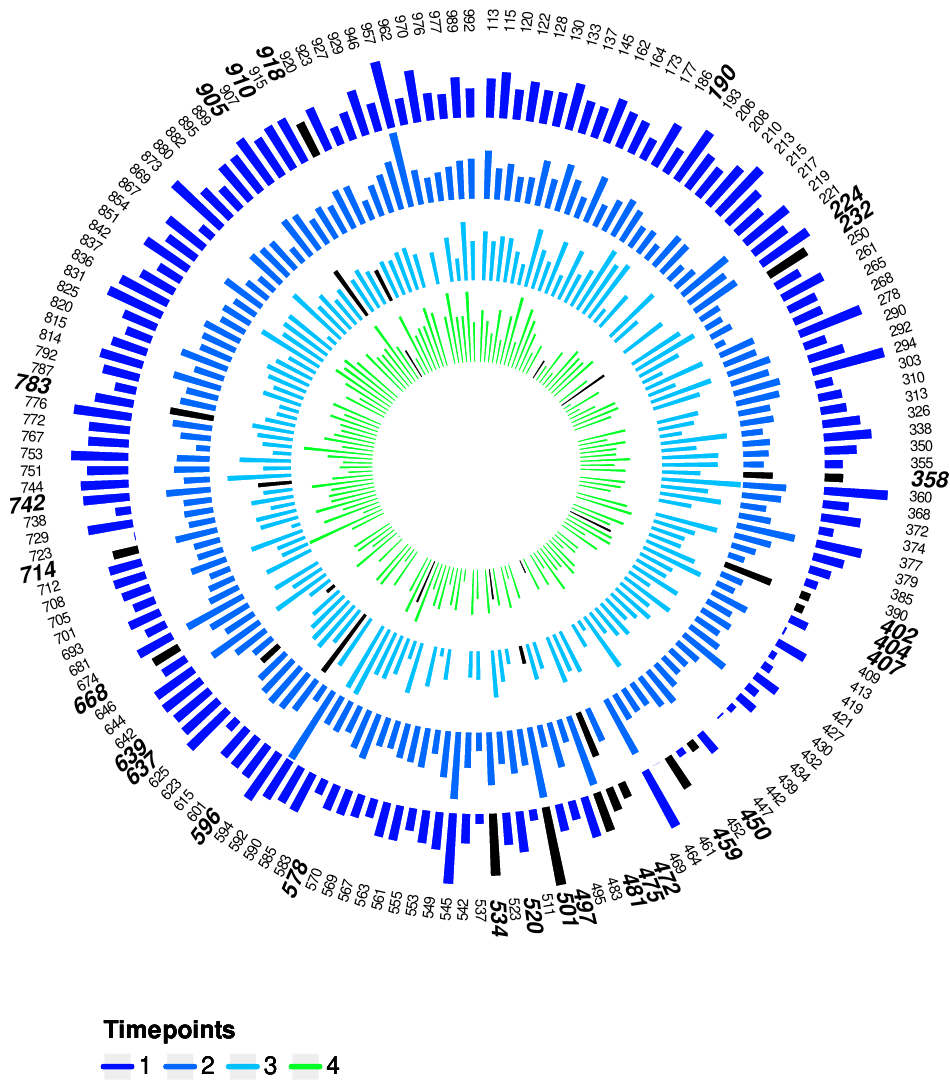
Figure 2. Circos plot for alanine. Each individual’s label is shown in the outer circle, with bold font indicating those who have been flagged. The length of a bar within a time point has been scaled to represent the width of the central 95% posterior predictive interval. Flagged individuals have a black bar at the flagged time point. No bar indicates that the individual had no data for that time point. There was a significant relationship between several metabolites and sex, whereas some metabolites had a significant relationship with age and BMI. Table 1 shows the estimates of the regression coefficients for sex, age and BMI for each metabolite, with 95% credible intervals. To assess convergence, four chains were run for each of the twenty metabolites, with an average PSRF of 1.0003 (standard deviation 0.0003) for each of the parameters ( β 0 , β 1 , σ 2 and σ 2 (cid:101)